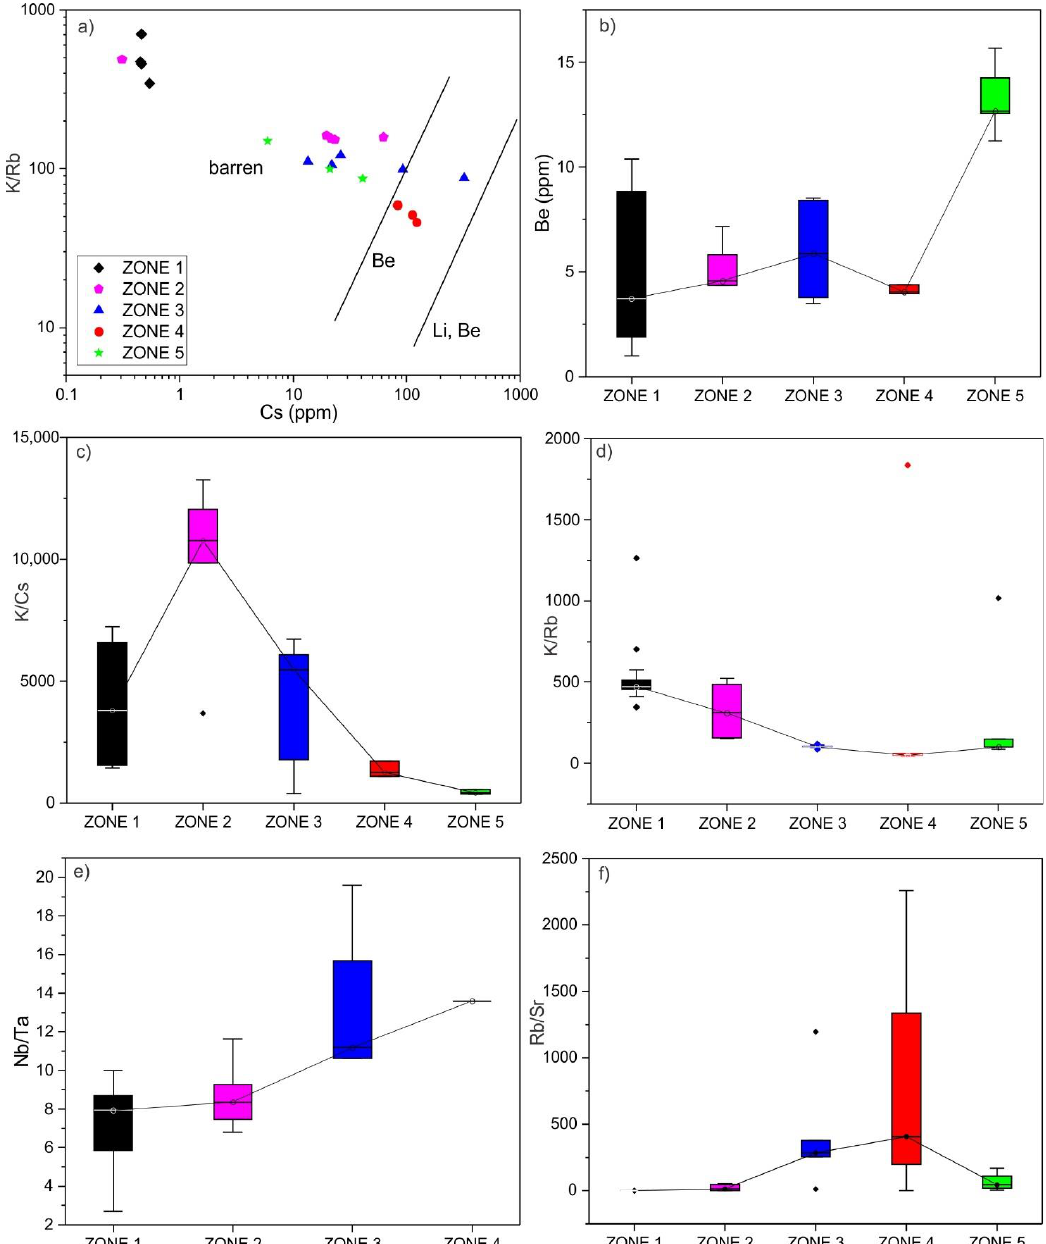
Figure 10. ( a ) Plot of K/Rb vs. Cs (ppm); Box and whisker plots of ( b ) Be; ( c ) K/Cs; ( d ) K/Rb; ( e ) Nb/Ta; ( f ) Rb/Sr of alkali feldspar from five zones of the Yamrang Pegmatite. Connecting lines join the median value. Ratios are calculated as ppm/ppm. Discrimination lines of barren, Be-, and Li, Be- pegmatites are from [39] as presented in [40].